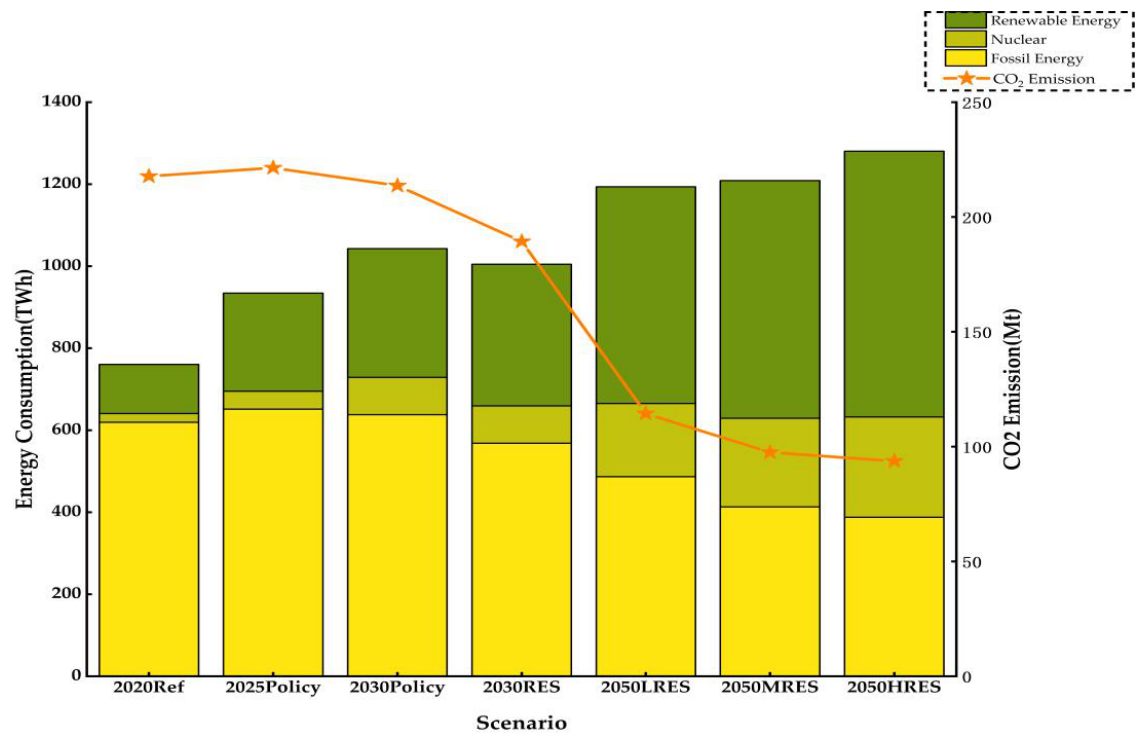
Figure 7. Total primary energy consumption and their carbon emissions. Table 9. CO 2 emission factors for different